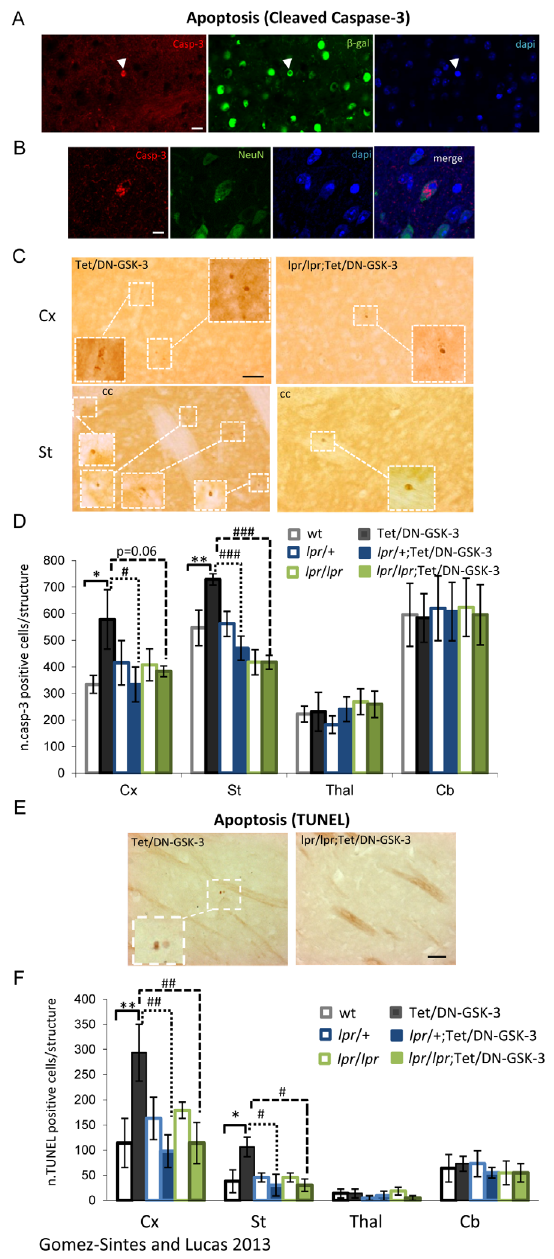
Figure 2. Analysis of apoptotic levels in experimental mice. A. Double labeling immunofluoresce with anti-cleaved caspase-3 (red) and b -gal (green) antibodies. Scale bar in left panel corresponds to 20 m m. B. Double labeling immunofluoresce with anti-cleaved caspase-3 (red) and NeuN (green) antibodies. Right panel shows a merged image of caspase-3, NeuN and dapi counterstaining. Scale bar in left panel corresponds to 10 m m. C. Immunohistochemistry with anti-cleaved caspase-3 antibody. Left panels correspond to Cx (upper) and St (lower) of Tet/DN-GSK-3. Right panels correspond to Cx (upper) and St (lower) of lpr / lpr ;Tet/DN-GSK-3. Scale bar in upper left panel corresponds to 50 m m. D. Quantification of caspase-3 positive cells in cortex (Cx), striatum (St), thalamus (Thal) and cerebellum (Cb) of wt, Tet/DN-GSK-3, lpr / + , lpr / + ;Tet/DN-GSK-3, lpr/lpr and lpr / lpr ;Tet/DN-GSK-3 mice (4 male mice per genotype). For quantification, one every four serial 30 m